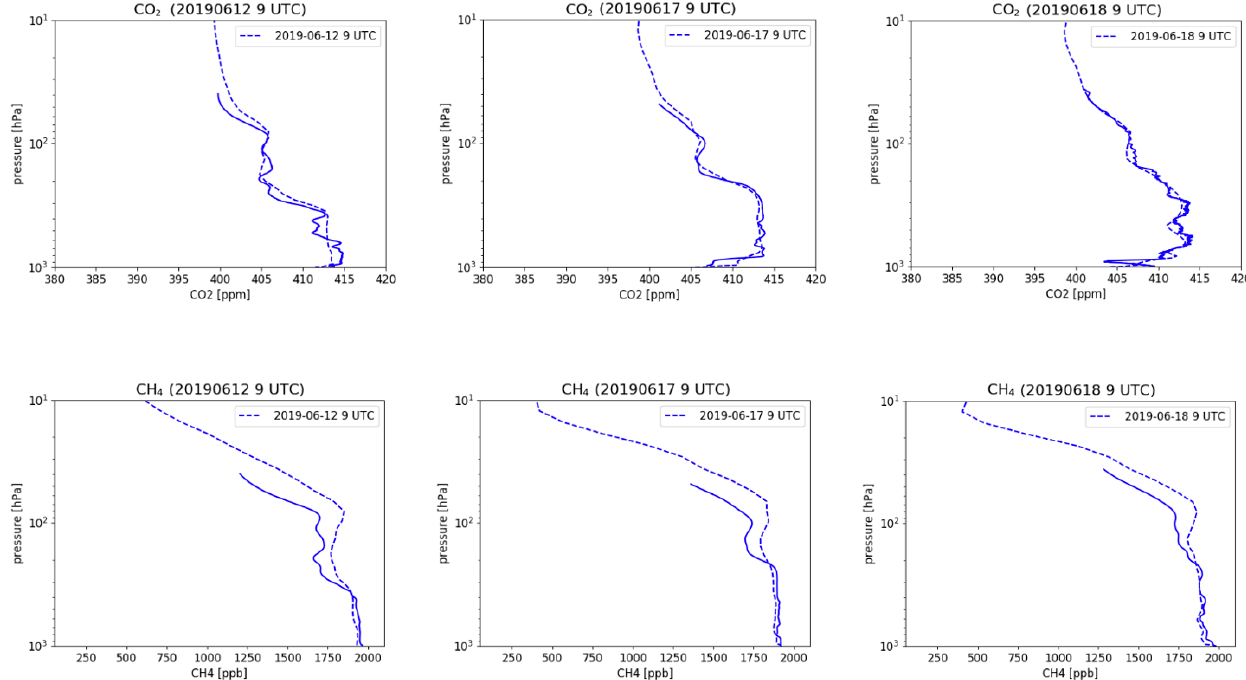
Figure 14. Vertical mole fraction profiles of CO 2 and CH 4 from the CAMS GHG reanalysis (dashed line) and AirCore observations (solid line) at Traînou (France; see Table A3) over the period in June